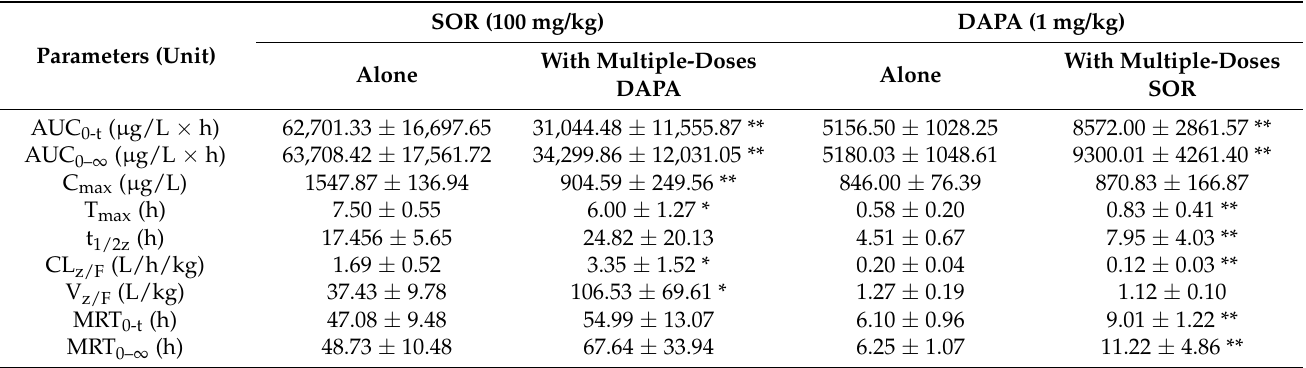
Table 4. Pharmacokinetic parameters of SOR and DAPA in rats after oral administration alone and combined multiple